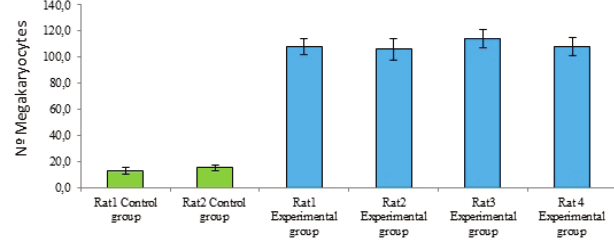
FIGURE 2 – Comparison between the individuals born from different female rats, in relation to the total number of megakaryocytes. The main bars are the mean values for the groups and the error bars represent their standard deviations.